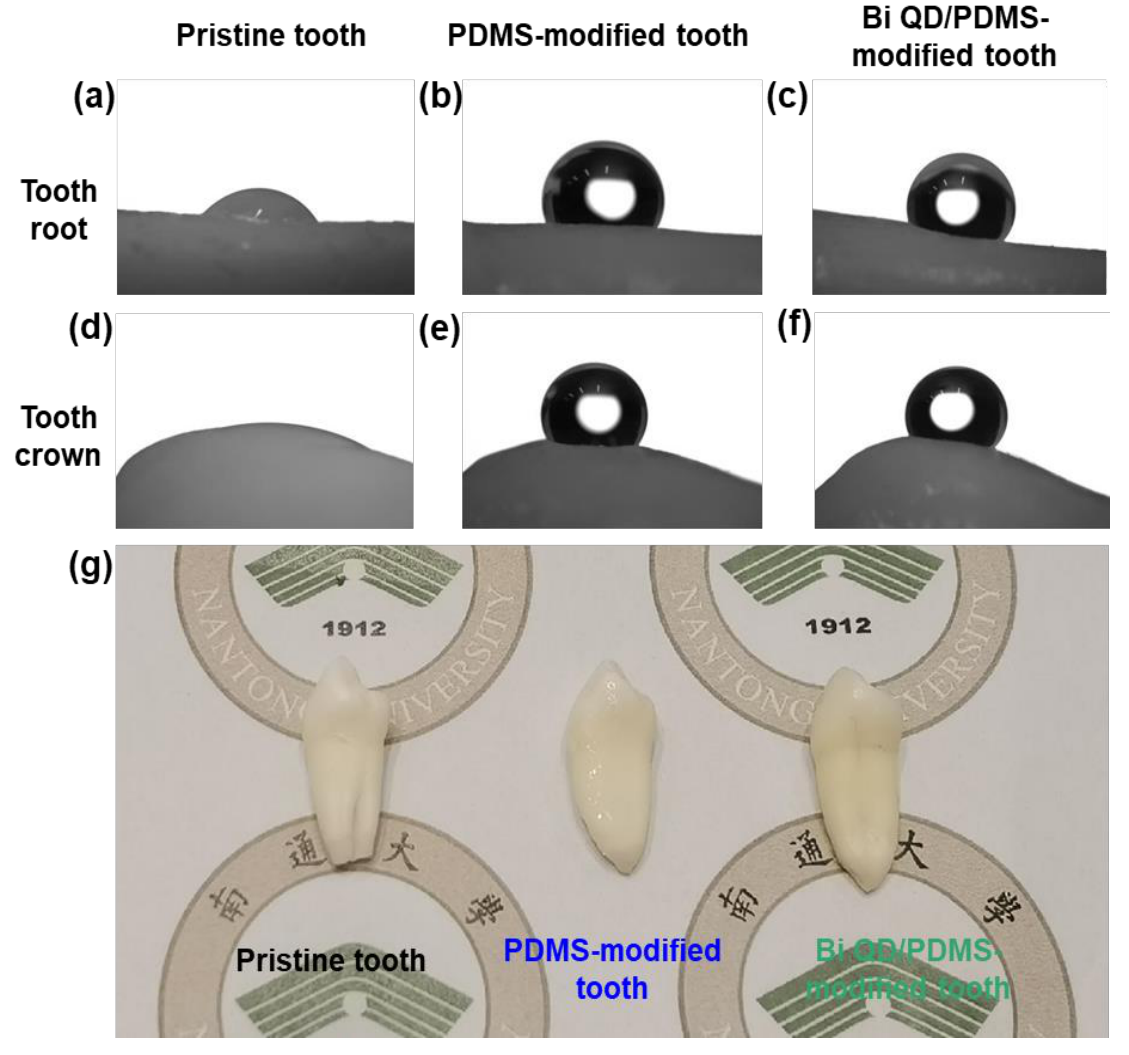
Figure 3. The change of θ and morphology after the modification of pristine tooth. The pictures for θ on the tooth root for ( a ) pristine tooth, ( b ) PDMS-modified tooth and ( c ) Bi QD/PDMS-modified tooth; the pictures for θ on the tooth crown for ( d ) pristine tooth, ( e ) PDMS-modified tooth and ( f ) Bi QD/PDMS-modified tooth. ( g ) The picture for real pristine tooth and modified tooth.